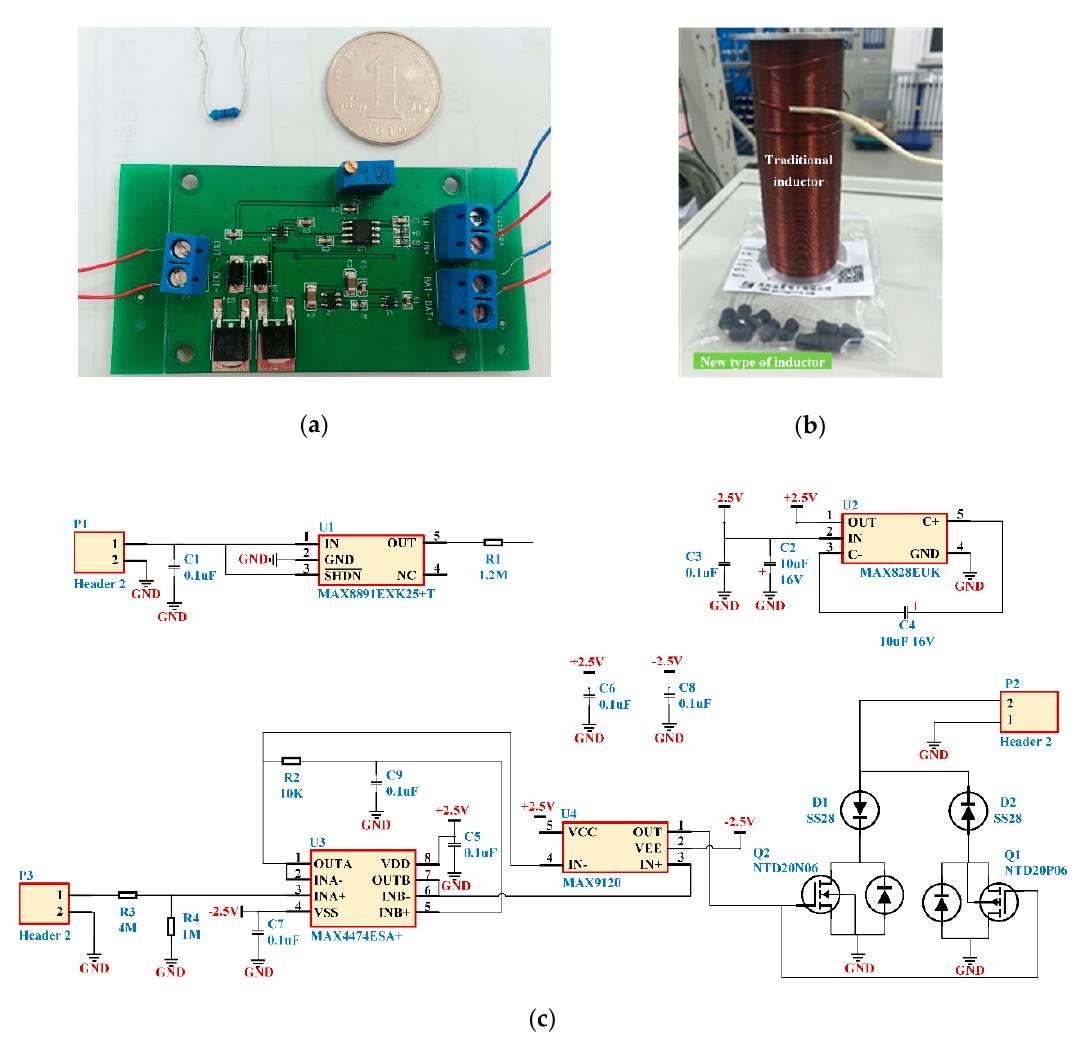
Figure 8. The implementation of the SSDI circuit: ( a ) the circuit board for the switching control; we also put a resistor and a coin (1 CNY) into the photo to illustrate the size of the board; ( b ) the employed inductor in comparison with the traditional winding coin inductor; ( c ) the schematic plot of the electric board.